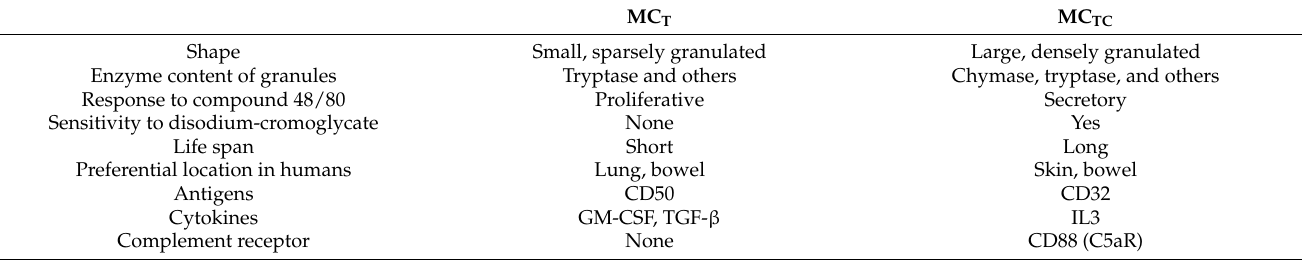
Table 1. Differences in some properties of MC T and MC TC .